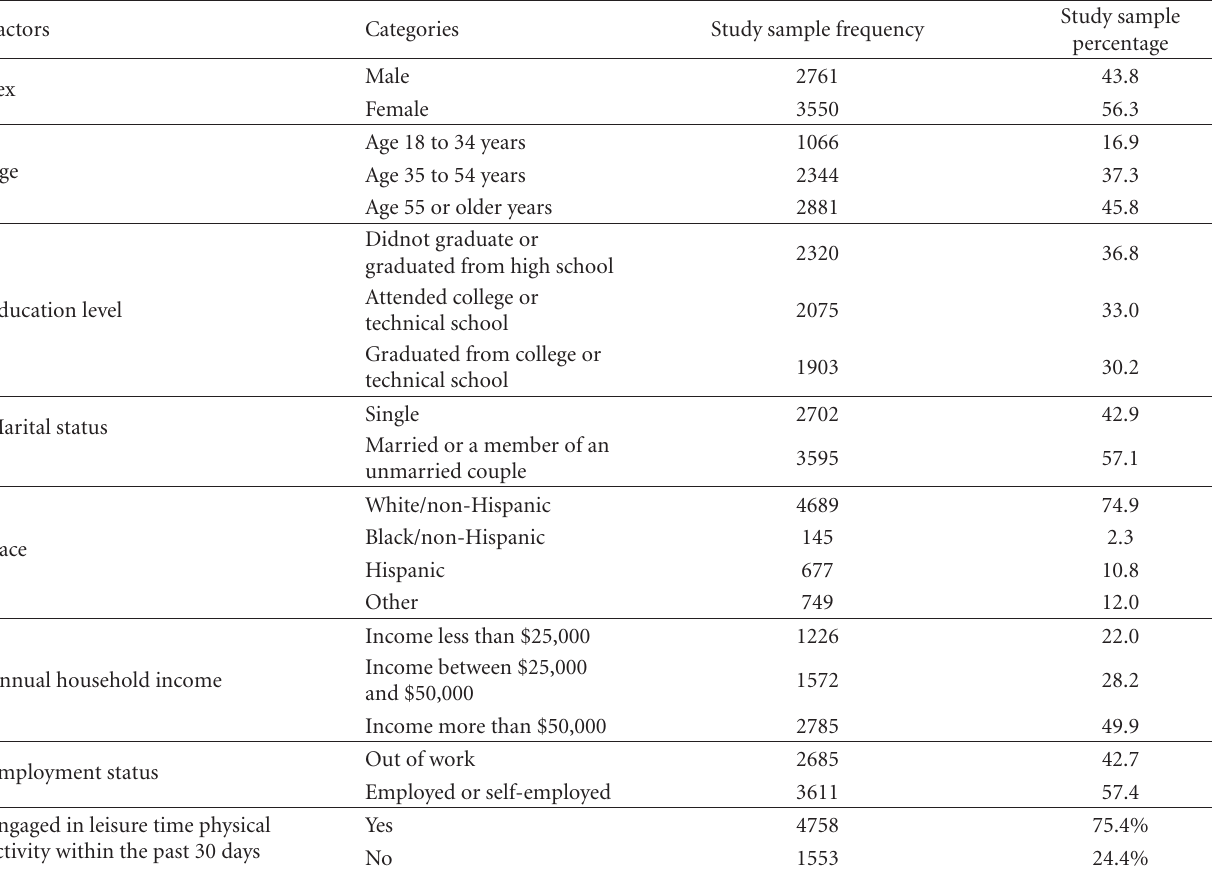
Table 1: Characteristics of study participants ( n =